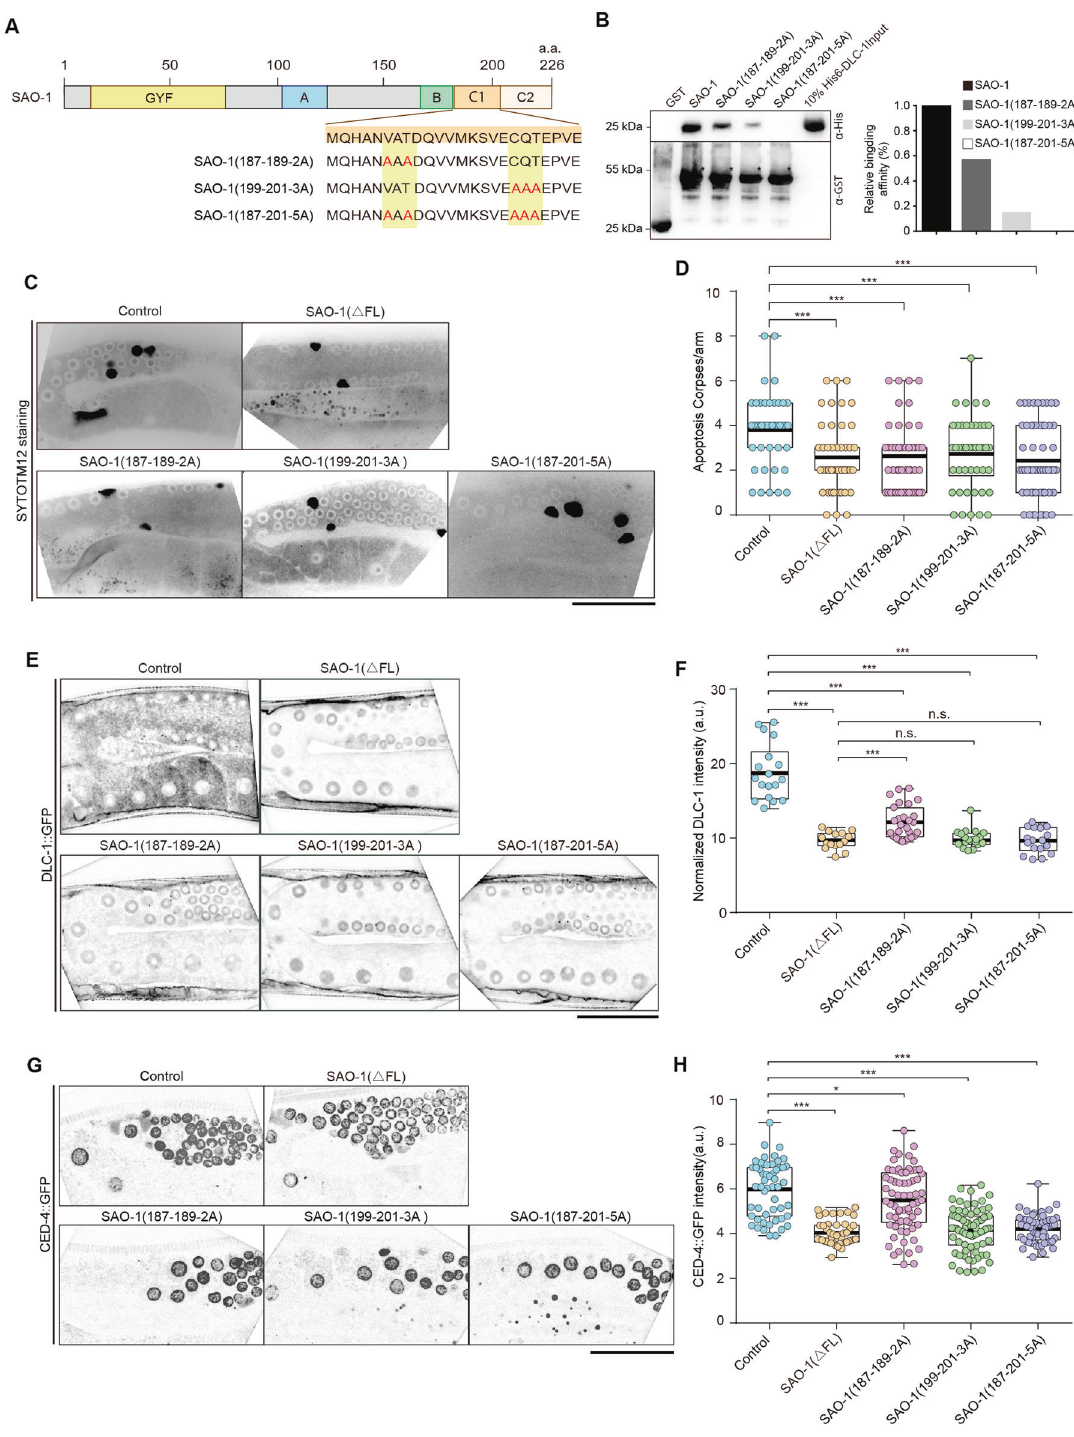
Fig. 5 SAO-1 C1 region interacts with DLC-1 and regulates germ cell apoptosis. A Schematic of SAO-1 protein domains. Below the protein residue alignment represents the point mutations in mutants. The mutated residue is highlighted with red color. B Western blot analysis of DLC-1 binding to puri fi ed GST, GST-SAO-1, GST-SAO-1(187-189-2A), GST-SAO-1(199-201-3A), GST-SAO-1(187-201-5A) using His antibody (top). GST-tag fusion proteins were visualized using GST antibody (bottom). Asterisks denote GST-tag fusion proteins. C Representative confocal images of apoptotic corpses in control, SAO-1( Δ FL), SAO-1(187-189-2A), SAO-1(199-201-3A), and SAO-1(187-201-5A). D Quanti fi cation of the number of apoptotic corpses in C , each dot in the chart represents a single worm. E Representative confocal images of DLC-1::GFP in control, SAO-1( Δ FL), SAO-1(187-189-2A), SAO-1(199-201-3A), and SAO-1(187-201-5A). F Quanti fi cation of normalized DLC-1::GFP intensity in E , each dot in the chart represents a single worm. G Representative confocal images of CED-4::GFP in control, SAO-1( Δ FL), SAO-1(187-189-2A), SAO- 1(199-201-3A), and SAO-1(187-201-5A). H Quanti fi cation of normalized CED-4::GFP intensity in G , each dot in the chart represents a single nuclear. Data were analyzed by two-tailed Student ’ s t test; Error bars, ±SEM; n.s. not signi fi cant. *p < 0.05, ***p < 0.001. a.u. arbitrary unit. Scale bar, 50 μ